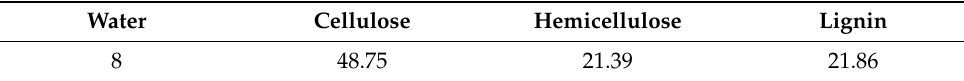
Table 11. Biochemical composition of pine–spruce–sawdust feedstock (%) [66].